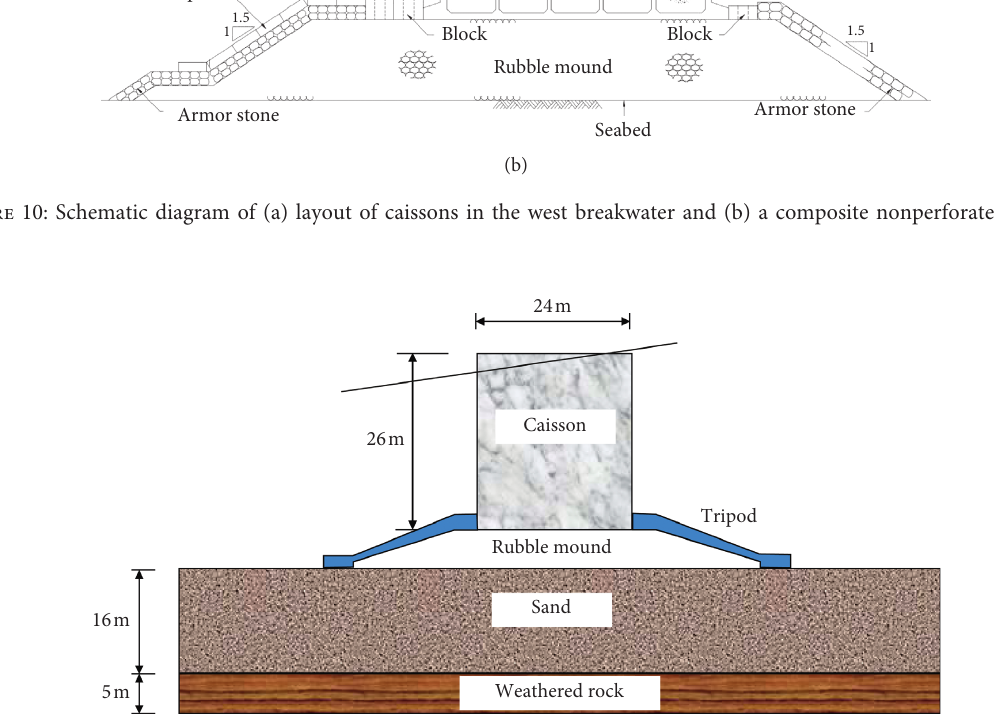
Figure 11: Cross-sectional view of the composite breakwater and its surround seabed formation for numerical analysis (unit: m).